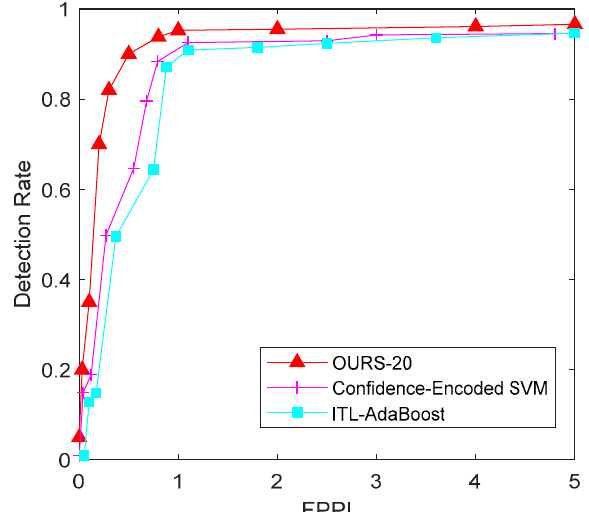
Figure 9. ROC curves of different algorithms under KITTI data set.